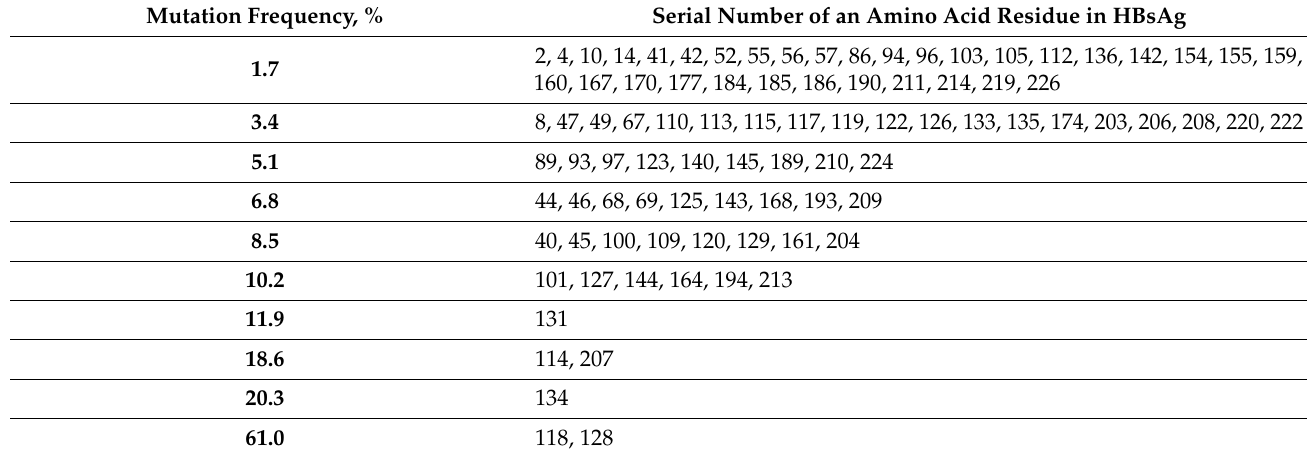
Table 3. Overall frequency of individual amino acid substitutions in patients with hematologic diseases (n = 59). Mutation Frequency,